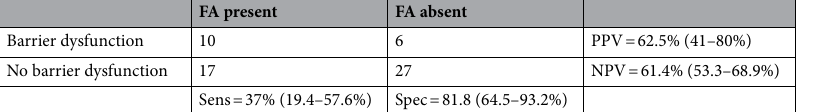
Table 3. Diagnostic performance of assessing barrier dysfunction in the colon by pCLE for the diagnosis of Food Allergy (FA). Sens, sensitivity; Spec, specificity. PPV, positive predictive value; NPV, negative predictive value. (95% CI).